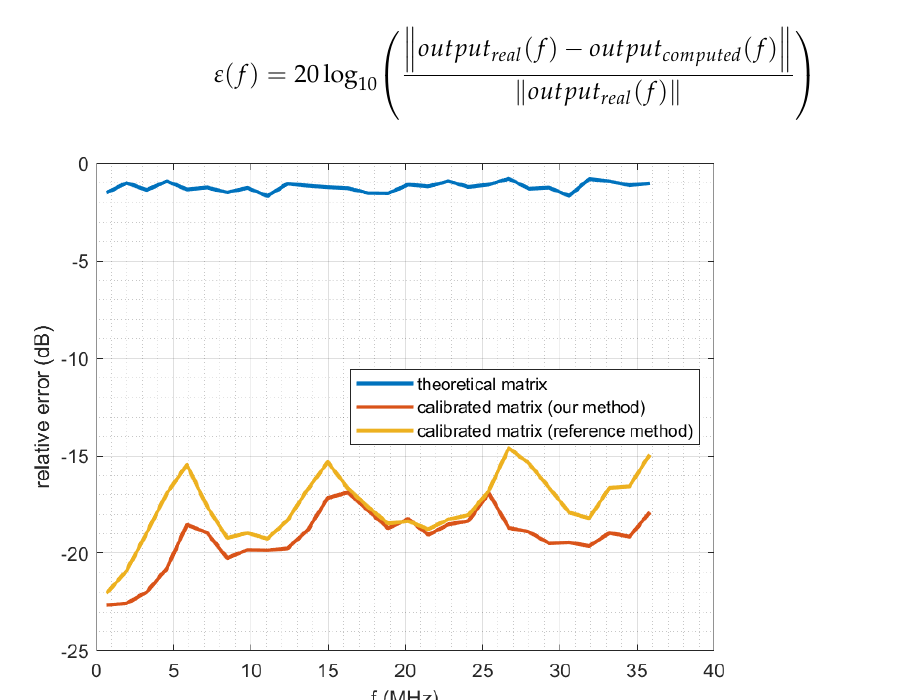
Figure 19. Relative error between computed and observed system output, as a function of output